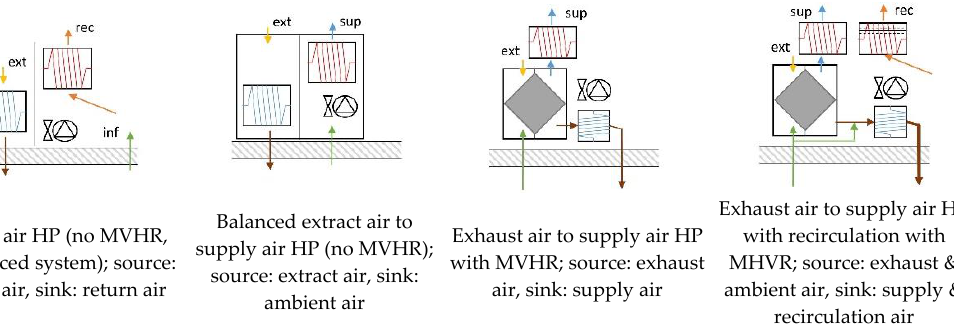
Figure 1. Schematic classification of air-to-air heat pumps (HP) with or without heat recovery and combined with or independent of MVHR; remark: refrigerant lines and fans not displayed for better